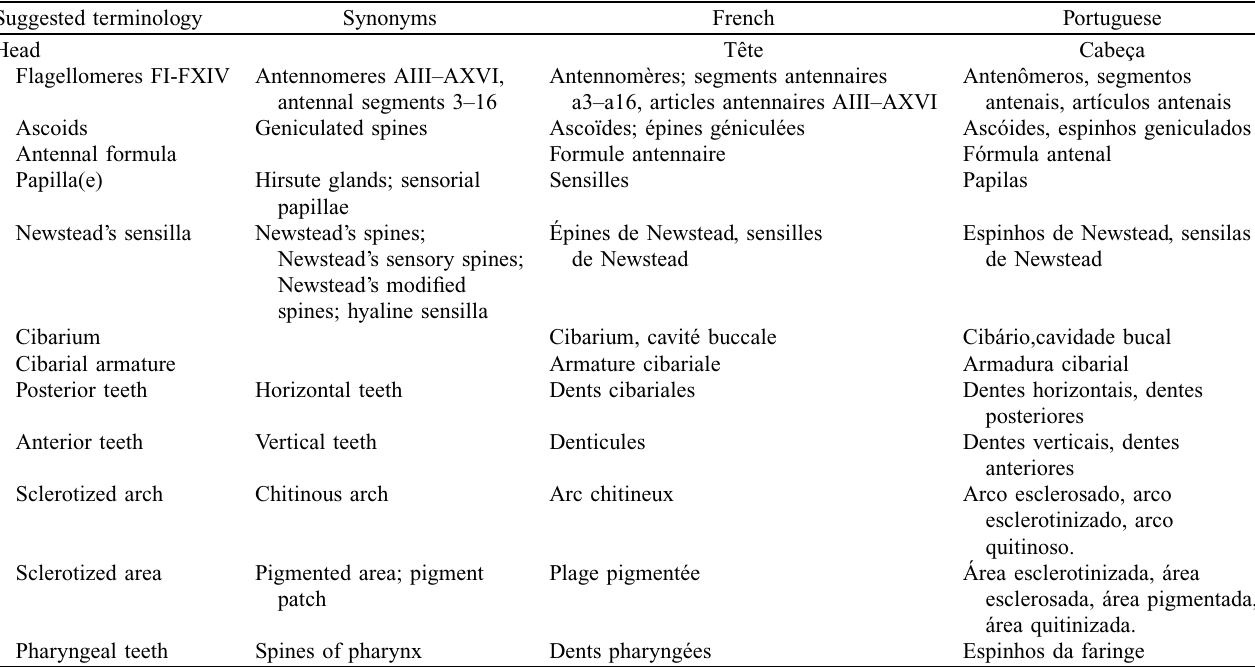
Table 2. Suggested terminology for main characters for the description of a new phlebotomine fly species and the most common synonyms; French and Portuguese